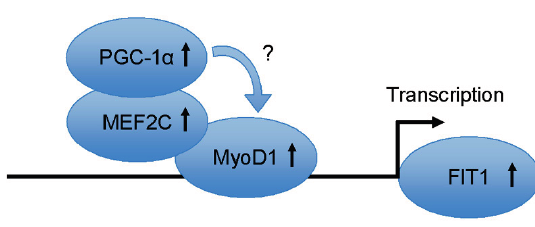
Figure 5. A proposed model to elucidate the activation of FIT1 by PGC-1 α via MyoD during